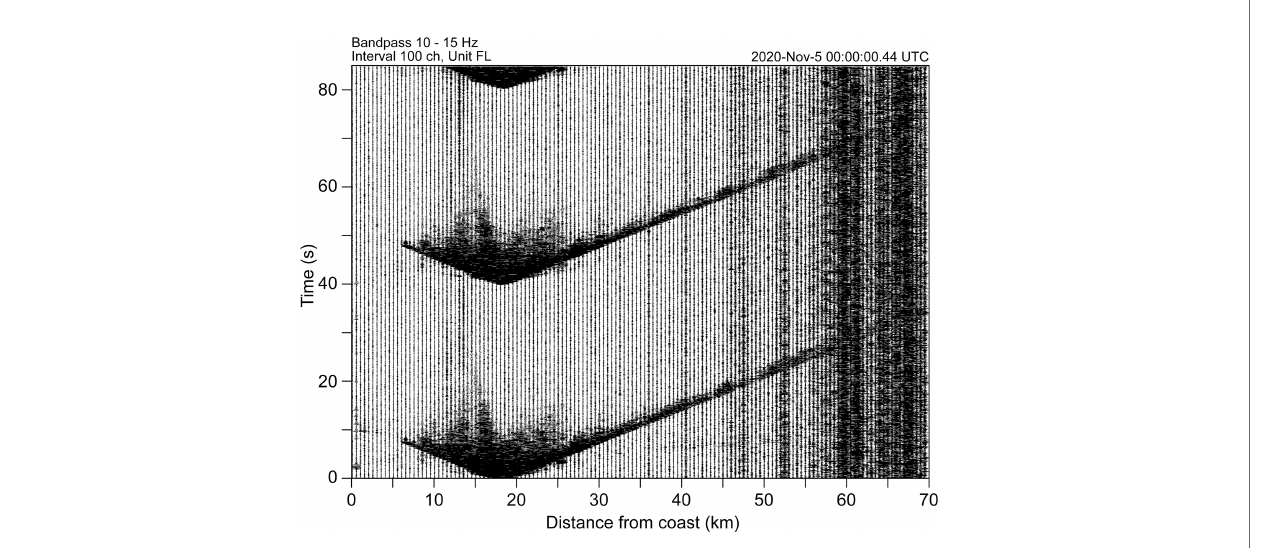
FIGURE 10 | Airgun records by the DAS measurements using the Sanriku cable observation system. The records of every 100 channels are plotted with a bandpass frequency fi lter. The horizontal axis indicates a distance from the interrogator, and the vertical axis is time. The DAS records have a high S/N ratio up to a distance of 60 km from the coast. Refracted and re fl ected waves were recognized until approximately 10 km from the seismic source.